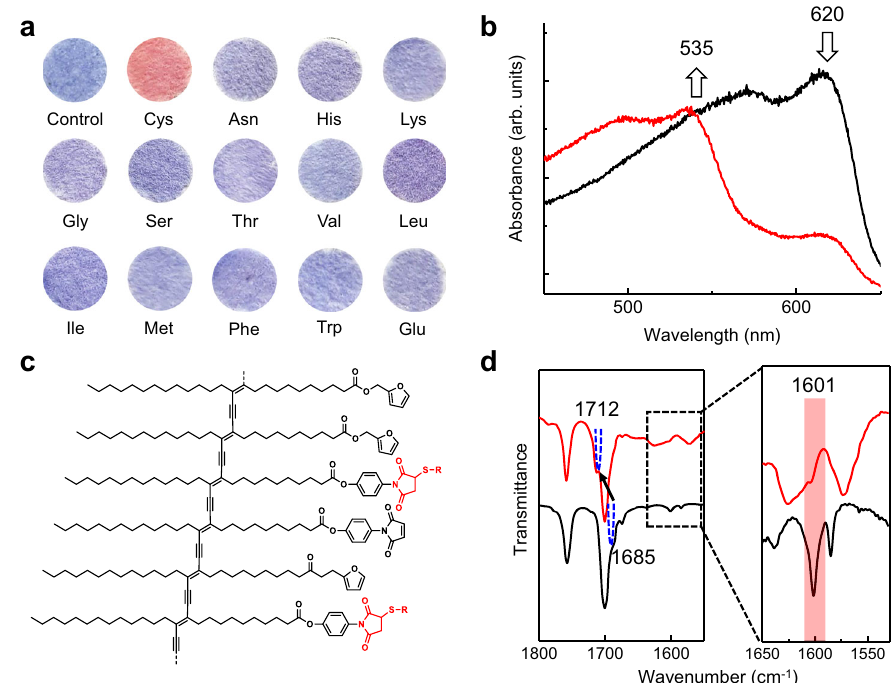
Fig. 7 Cysteine-promoted color change of retro Diels – Alder (rDA)-derived polydiacetylene (PDA). a Photographs of heat-treated (110 °C for 5 min) and UV irradiated (254 nm, 1 mW cm − 2 , 1 min) 1-endo-coated fi lter papers after exposure (30 min) to 10 mM of various amino acids in PBS buffer – EtOH mixture (1:1, v/v, pH: 7.4). b Visible absorption spectra of a PDA-coated fi lter paper (obtained as described in a ) before (black line) and after (red line) exposure to 10 mM of cysteine. c Partial structures of polydiacetylene containing thiol-maleimide adducts (red-colored structures). d FT-IR spectra in the region of maleimide stretching of PDA obtained with polymerization of M before (black line) and after (red line) exposure to 10 mM of